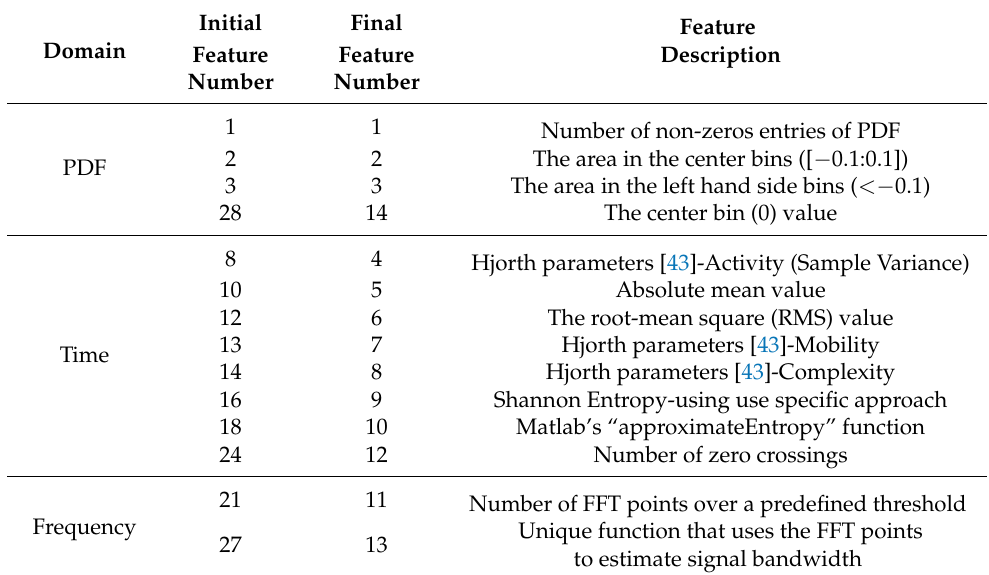
Table 3. PDF, Time and Frequency Domain-Optimized Features Extracted from the Raw Received I/Q